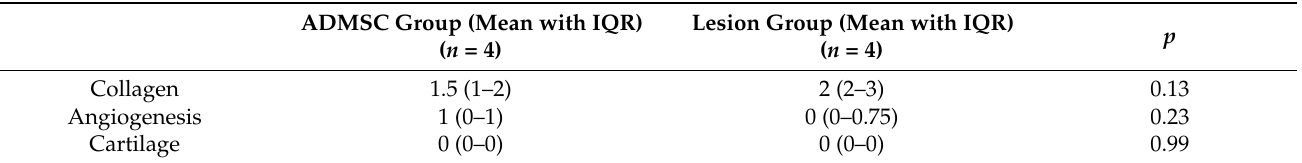
Table 5. Histopathology results with